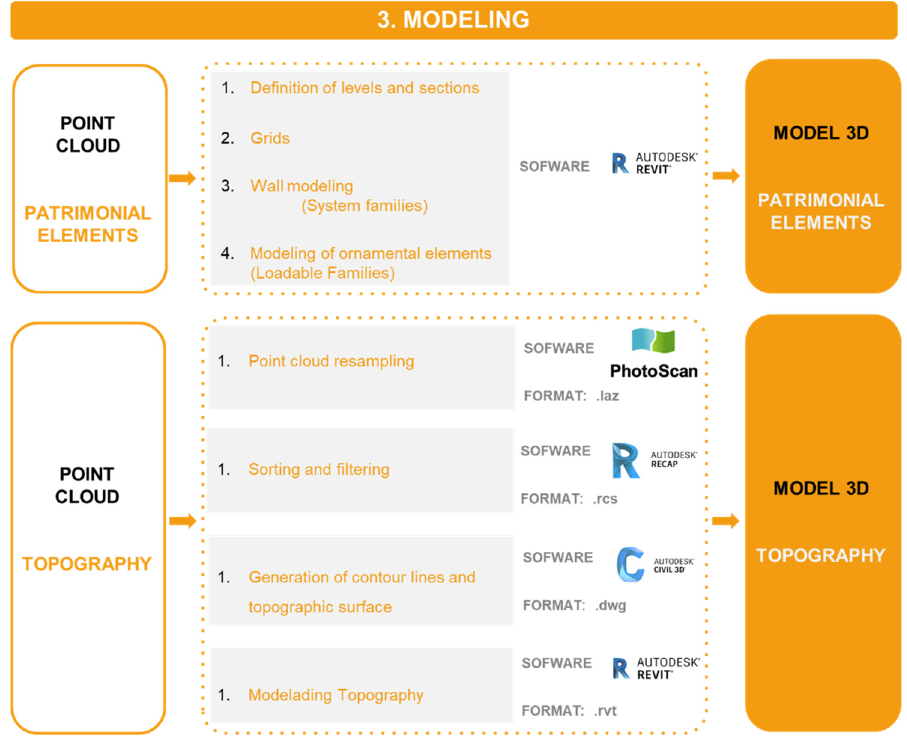
Figure 15. Diagram of the 3D modelling process from the point cloud obtained. Two different methods are defined, one for the buildings and the other for the topography.